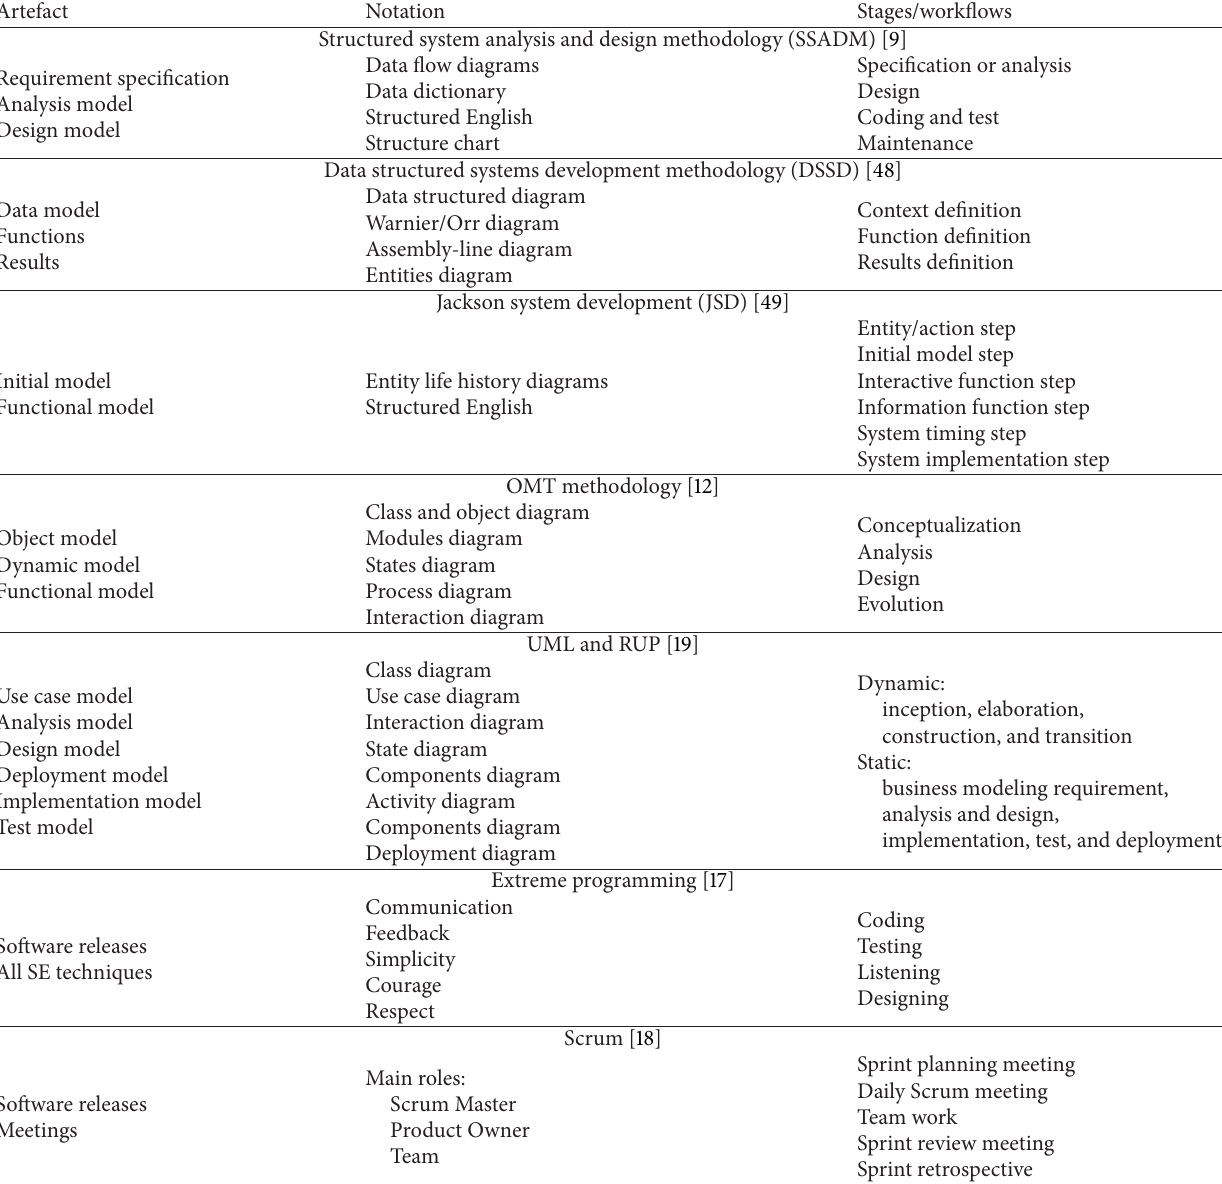
Table 2: SE methodologies